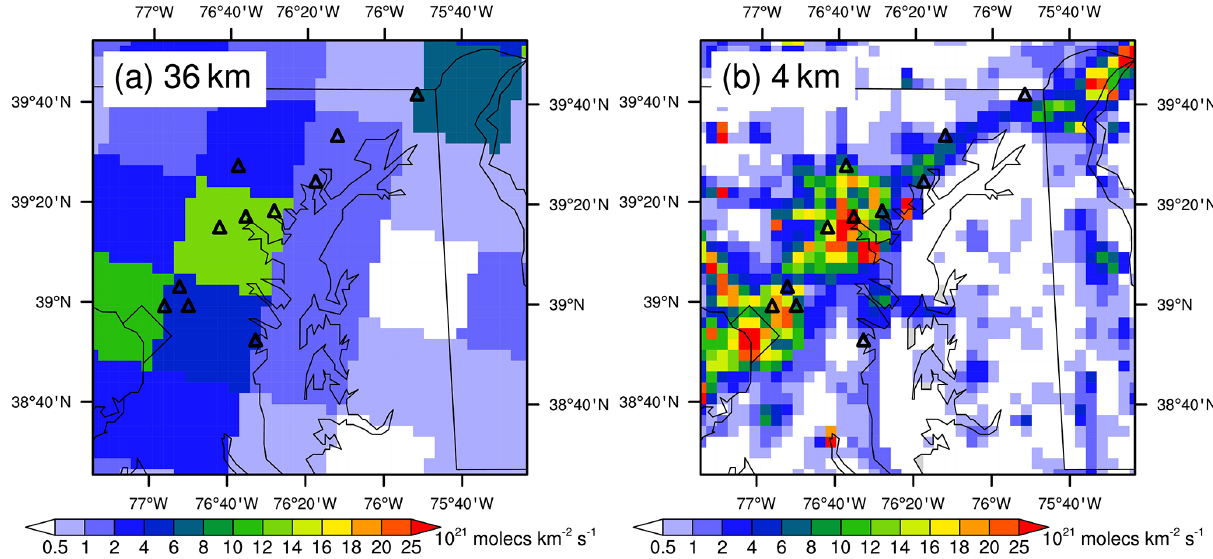
Figure 2. Distributions of NO x emissions for the (a) 36km and (b) 4km REAM simulations around the DISCOVER-AQ 2011 region. Here